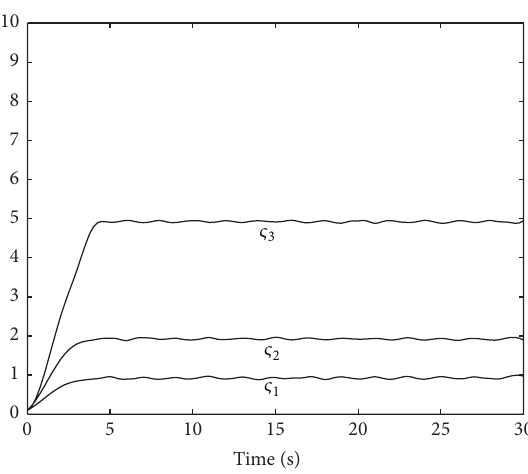
Figure 8: Trajectory of the system state 𝑥 3 .